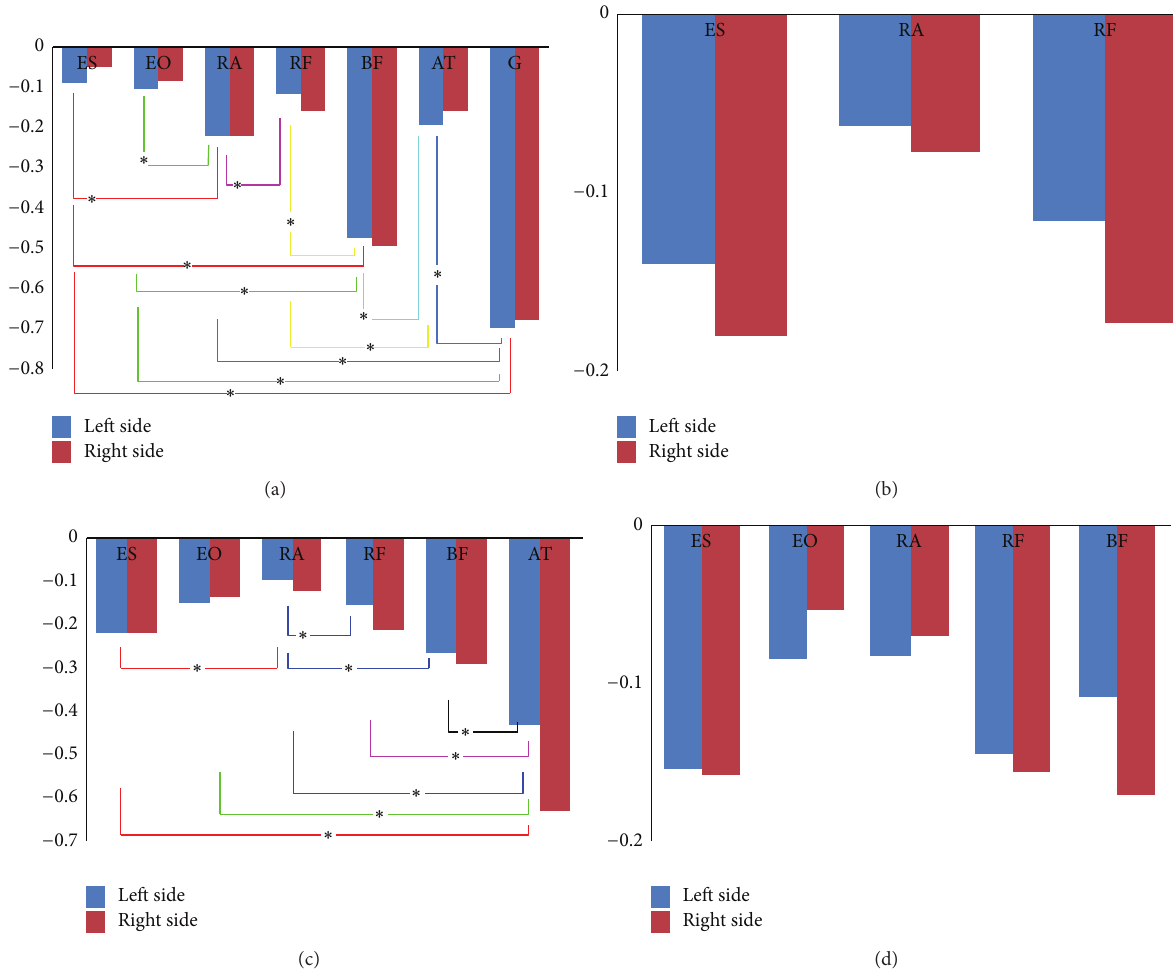
Figure 11: The MF slope of some muscles during the four rehabilitation exercises. The horizontal axis represents the muscles of left side and right side; the vertical coordinate represents the median frequency slope. (a) showed the results of prone bridge; (b) showed the results of supine bridge; (c) showed the results of unilateral bridge (lifting the right leg); and (d) showed the results of bird-dog exercise (lifting the left arm and right leg). “ ∗ ” represents that there was significant difference between the two